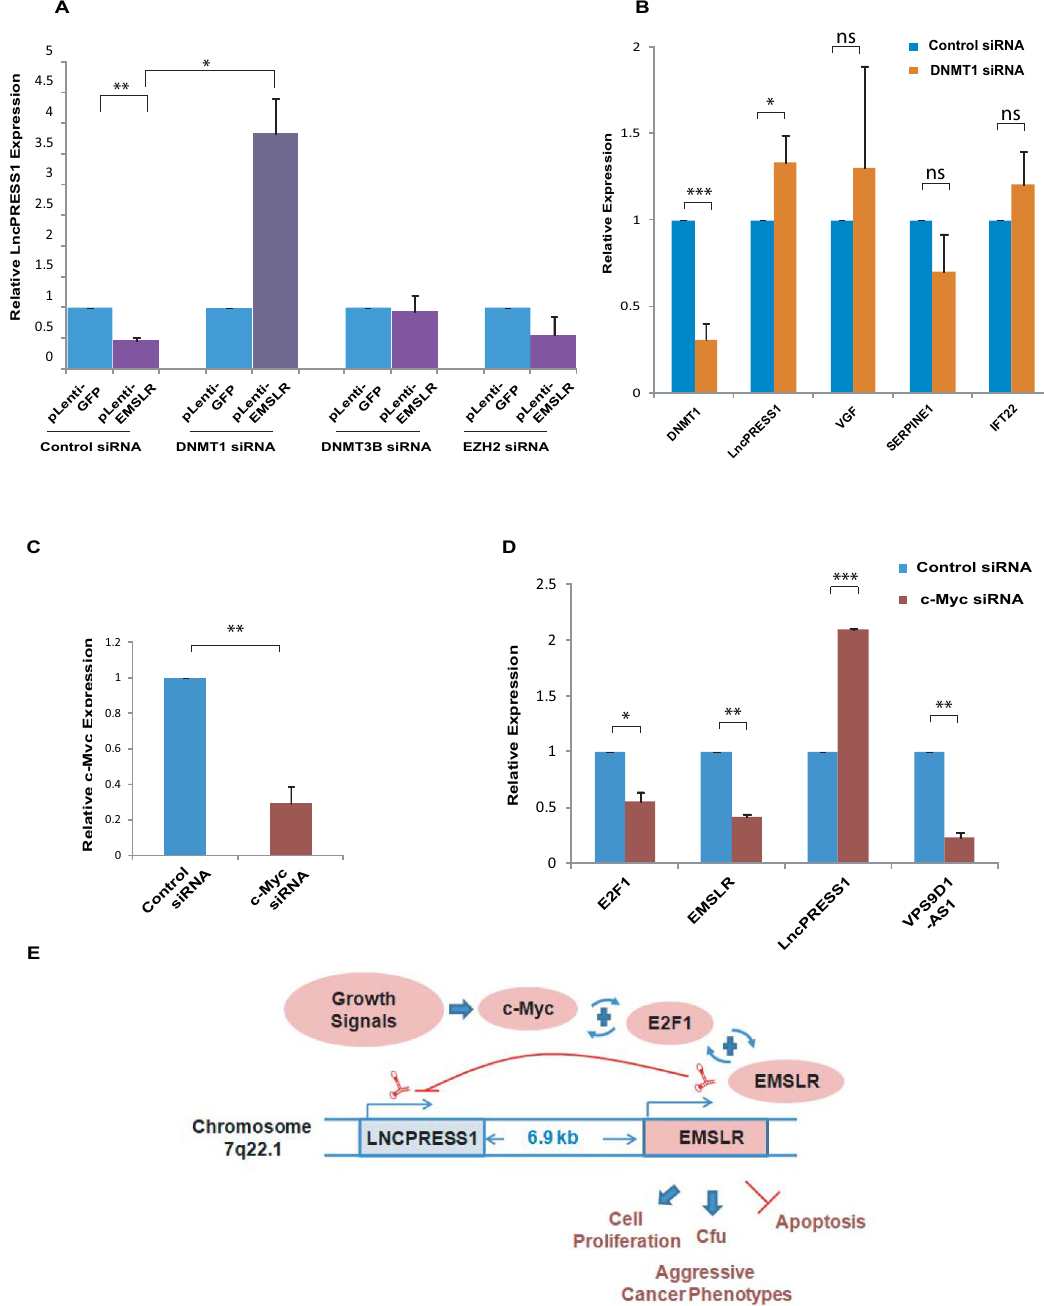
Figure 6. C-MYC signal transduction pathways control LncPRESS1 expression . ( A ) The transcriptional repression of LncPRESS1 mediated by EMSLR is dependent on DNA Methyltransferase 1. A549 cells were transduced with lentiviral expressing either control vector or EMSLR followed by puromycin selection to obtain stable cells. Control or EMSLR stably overexpressing A549 cells were then transfected with control GL2 siRNA or siRNA targeting DNMT1 , DNMT3B or EZH2 followed by quantification of LncPRESS1 levels by individual quantitative real-time PCR with GAPDH as an endogenous control. The levels of LncPRESS1 observed after different siRNA transfections in EMSLR expressing stable cells were normalized to non- EMSLR expressing cells. ( B ) Effect of DNMT1 depletion on the expression of genes located in the vicinity of LncPRESS1 . A549 cells were transfected on three consecutive days with control GL2 or DNMT1 siRNA and the levels of indicated genes were quantified by individual quantitative real-time PCR. GAPDH was used as the endogenous control for normalization of lncRNA expression. ( C – D ), Myc signal transduction pathways control LncPRESS1 expression. A549 cells were transfected with control GL2 or siRNA targeting C-MYC followed by quantification of C-MYC , E2F1 , EMSLR , LncPRESS1 and VPS9D1-AS1 levels by individual quantitative real-time PCR. GAPDH was used as the endogenous control for normalization. The data is represented as mean of two independent experiments ± S.D. p values were calculated using two-tailed t-test (* p < 0.05; ** p < 0.01, *** p < 0.001, ns, non-significant). ( E ) An illustration depicting that positive feedback loops connect C-MYC and E2F1 signals to cell cycle control . The model is based on the following observations: (i) C-MYC and E2F1 activate each other’s transcription 47 , depicted by a ‘ + ’ sign; (ii) C-MYC induces EMSLR which stabilizes E2F1 mRNA 23 ; (iii) Our observations that EMSLR expression is dependent on E2F1 and EMSLR represses LncPRESS1 . The LncPRESS1 gene is located 6.9 kb upstream of the E2F1 -dependent lncRNA, EMSLR and both are expressed in the same direction from the cytogenic band 7q22.1. CFU stands for colony-forming